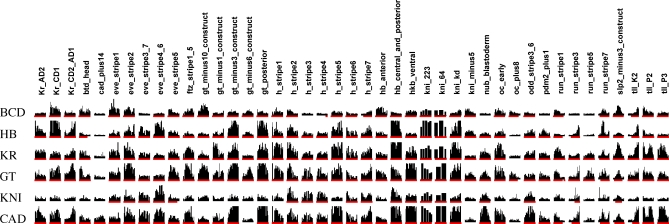
Known cis-Regulatory Modules Involved in Anterior–Posterior Patterning Are Highly Bound by Multiple FactorsOligonucleotide ratio scores for BCD1, HB1, KR1, GT, KNI2, and CAD for all cis-regulatory modules known to, or strongly believed to, be targeted by one or more of these factors prior to this study [8,9,33,103]. Only oligos within the region tested to demonstrate enhancer activity are shown. Red lines mark 1% FDR regions.